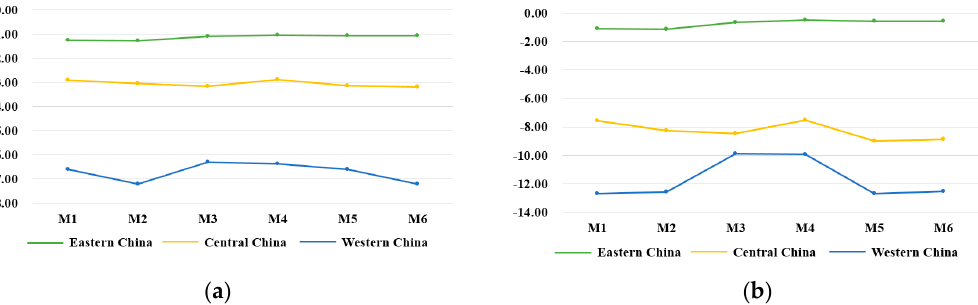
Figure 8. Impacts of the trading mechanism on regional carbon emissions with different regional abatement rates under scenarios M1–M6 in 20th year (%). ( a ) Regional carbon emissions, ( b ) regional GDP.